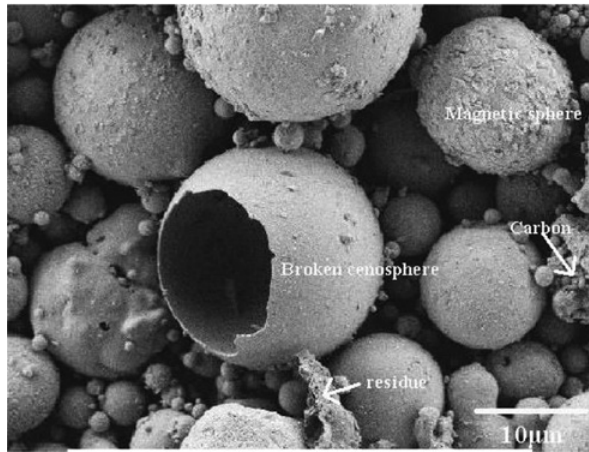
Figure 2: SEM image of fly